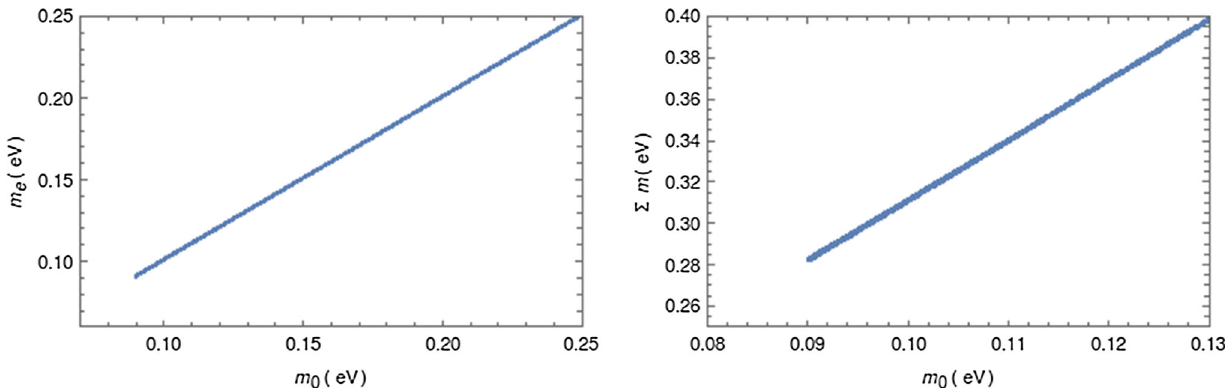
Fig. 8 Neutrino mass and the sum of the neutrino masses versus m 0 , respectively and 0 . 005 ≤ | (cid:4) | ≤ 0 . 023. As we can observe, the